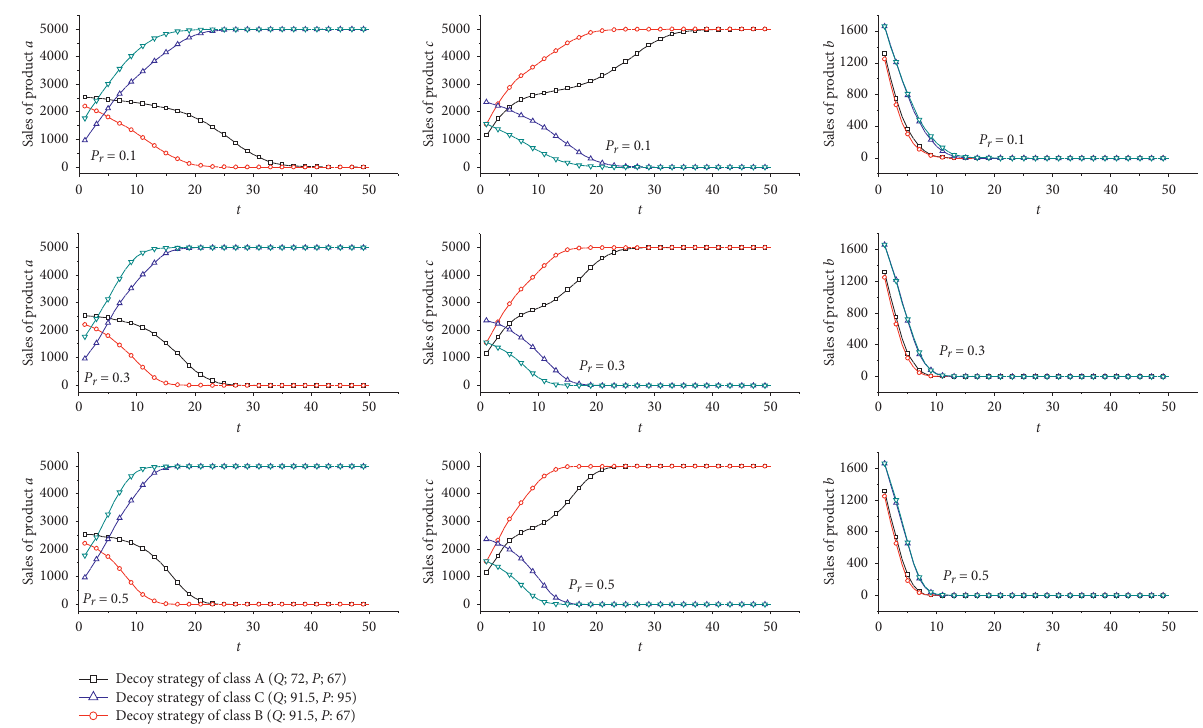
Figure 8: Evolution trends for sales of products a , c , and b under different true decoy strategies in scenarios with different reconnection